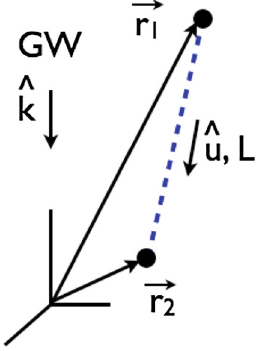
Fig. 24 Geometry for calculating the change in the photon propagation time from (cid:5) r 1 to (cid:5) r 2 = r 1 + L ˆ u in the presence of a plane gravitational wave propagating in direction ˆ